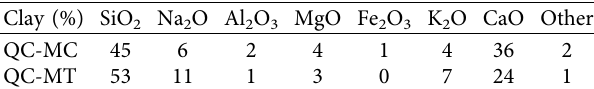
Figure 1: XRD patterns for (a) QC-MC and (b) QC-MT. Table 1: Elemental composition of QC-MC and QC-MT deter- mined by ICP-MS.